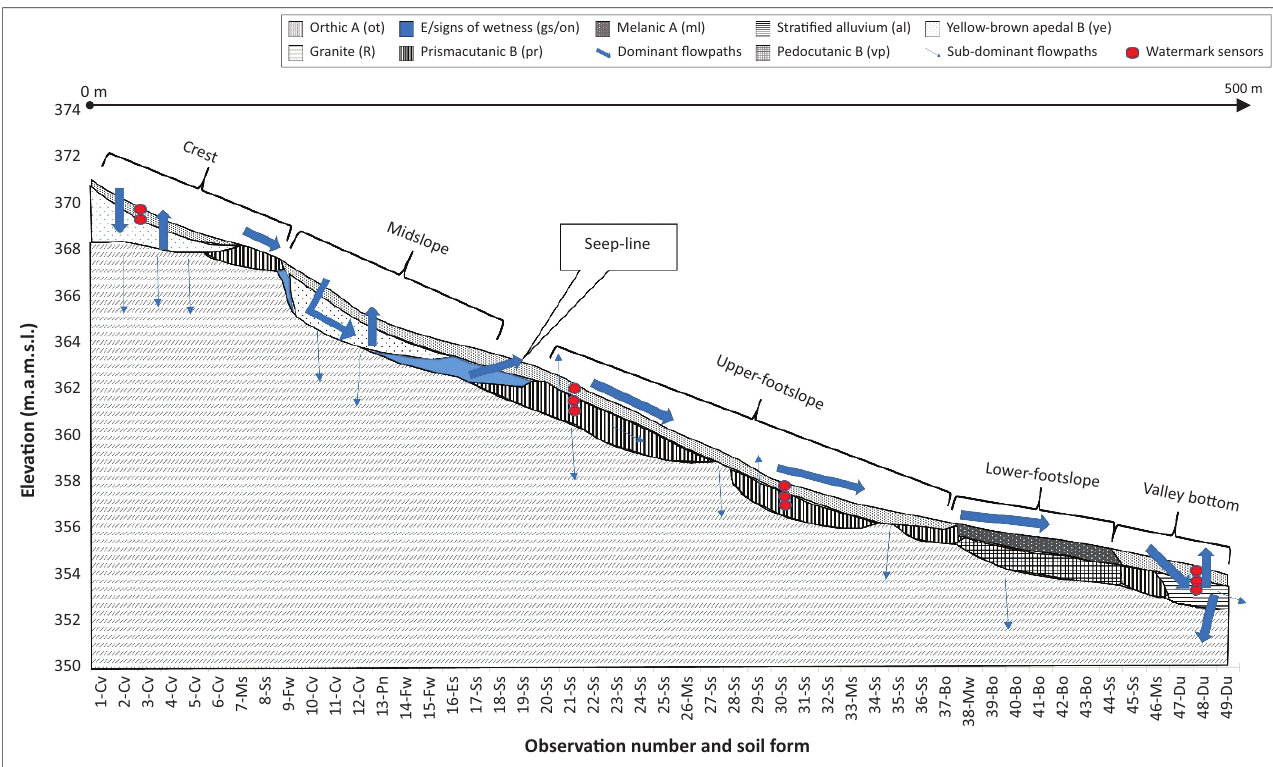
FIGURE 1: Hydropedological behaviour inferred from soil distribution pattern, different landscape units and location of watermark sensors on the studied